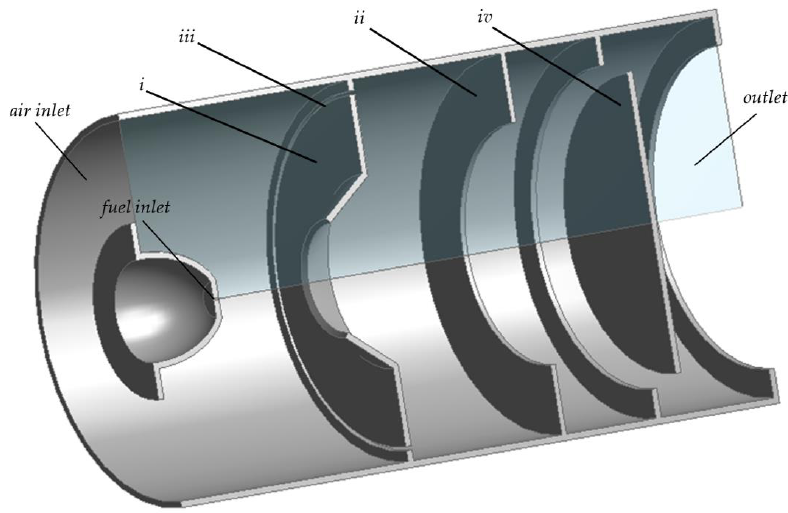
Figure 1. Three-dimensional sectional view of the burner. i: Ring cone; ii: ring cup; iii: slit; iv: mixing plate.